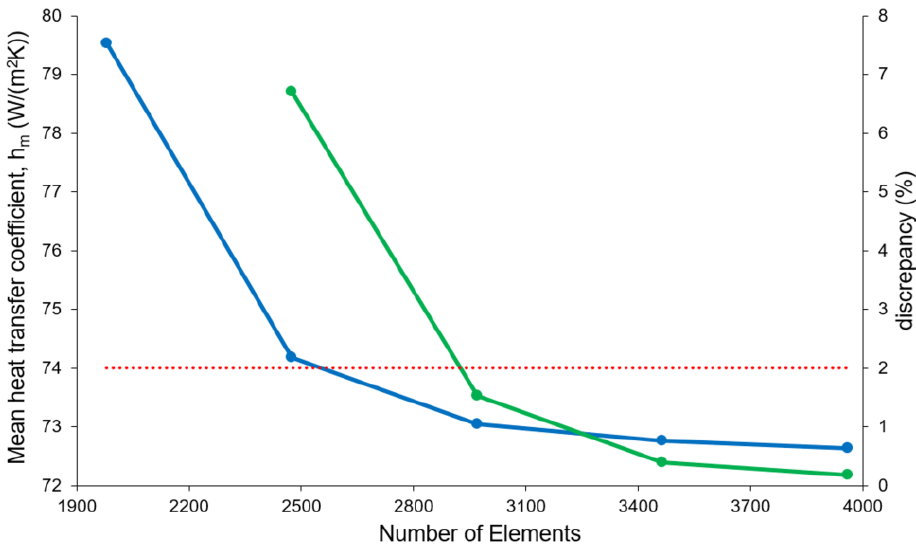
Figure 2. Mesh dependency test.